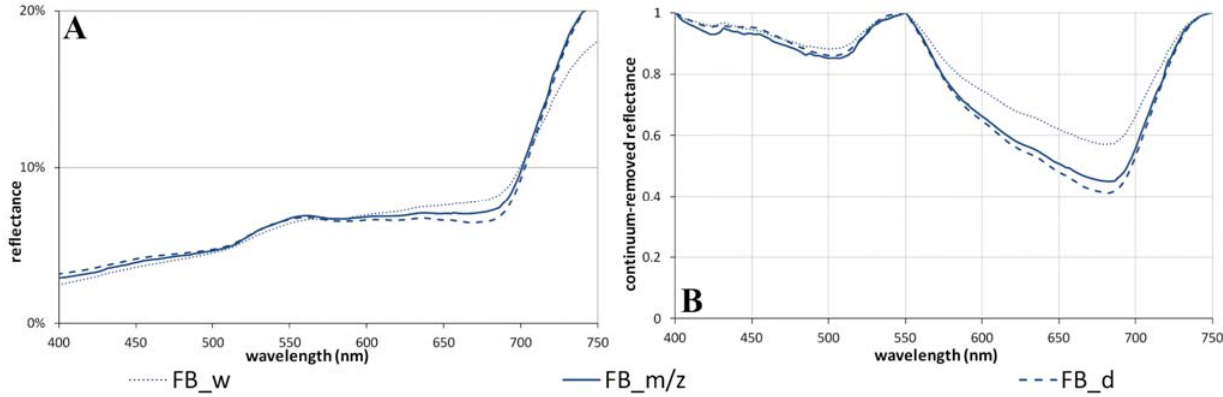
Figure 12. Spectral characteristics of the soil moisture gradient at the Franklin Bluffs study location. Comparison of ( A ) the averaged reflectance spectra in the visible (400–700 nm), and ( B ) the continuum-removed absorption features in the blue (400–550 nm) and red (550–750 nm) wavelength